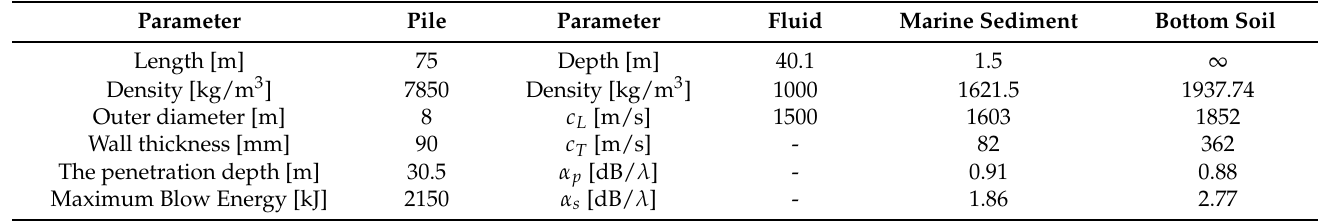
Table 2. Basic input parameters for the validation case for project